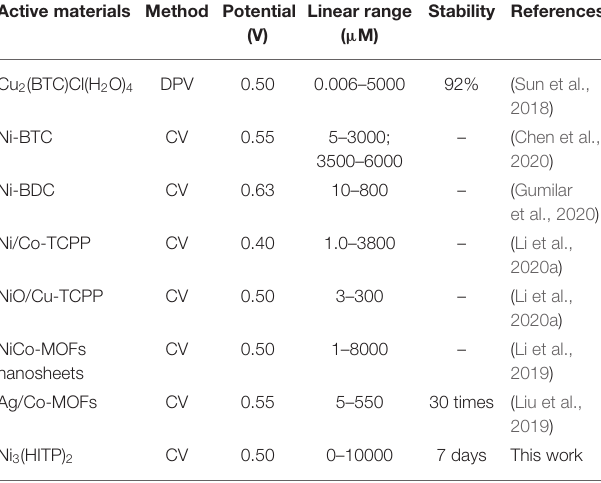
Linear range (V) ( µ